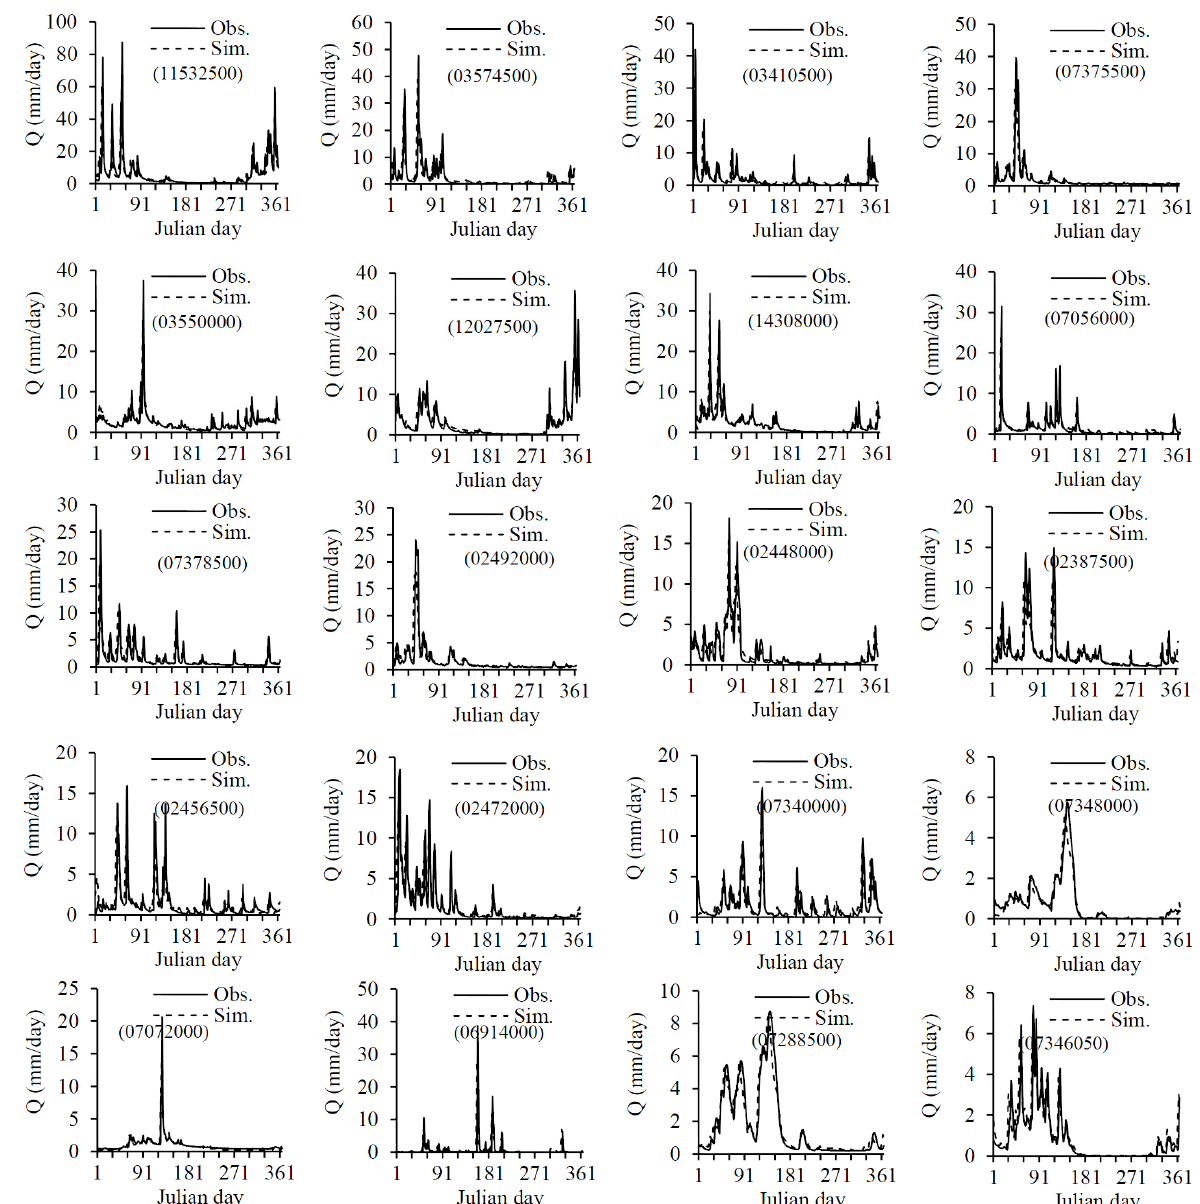
Figure 2. Validated daily hydrograph of 20 analyzed river basins (calibrated with mean year input data sets). MOPEX ID is presented in